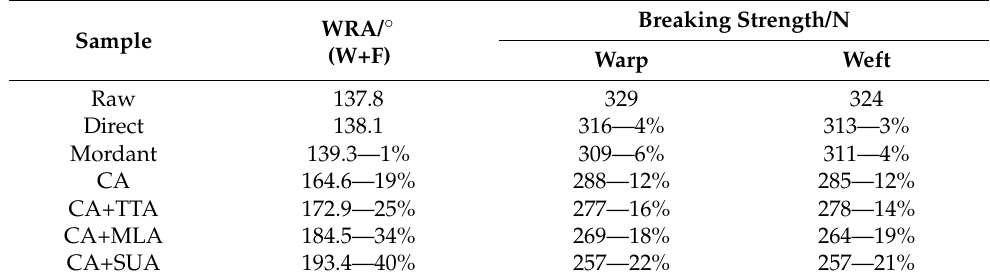
Table 6. Wearing property of the raw, direct, mordant, and cross-linked dyed cotton